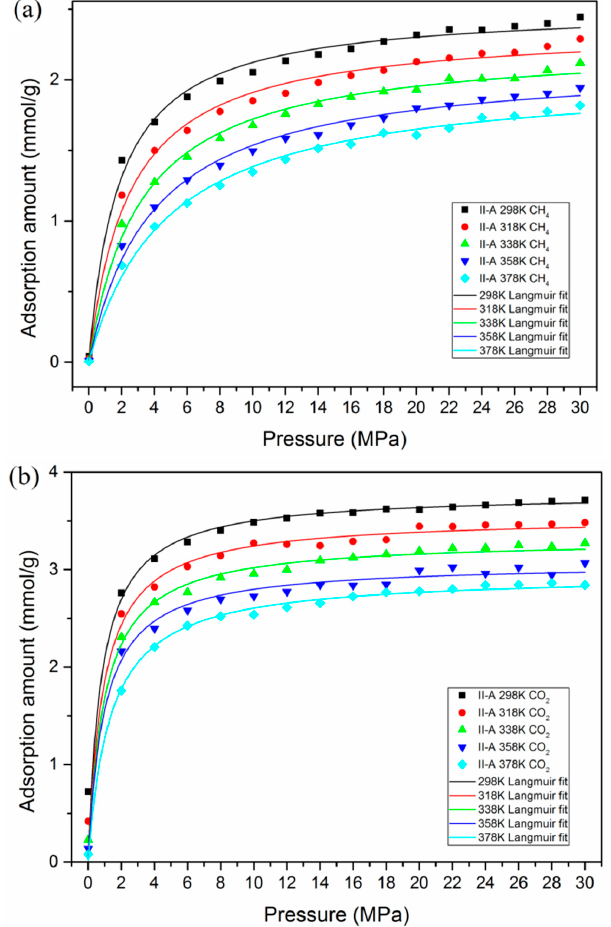
Figure 3. The adsorption isotherms of CH 4 and CO 2 at different temperatures and Langmuir fitting: ( a ) CH 4 ; ( b ) CO 2 .